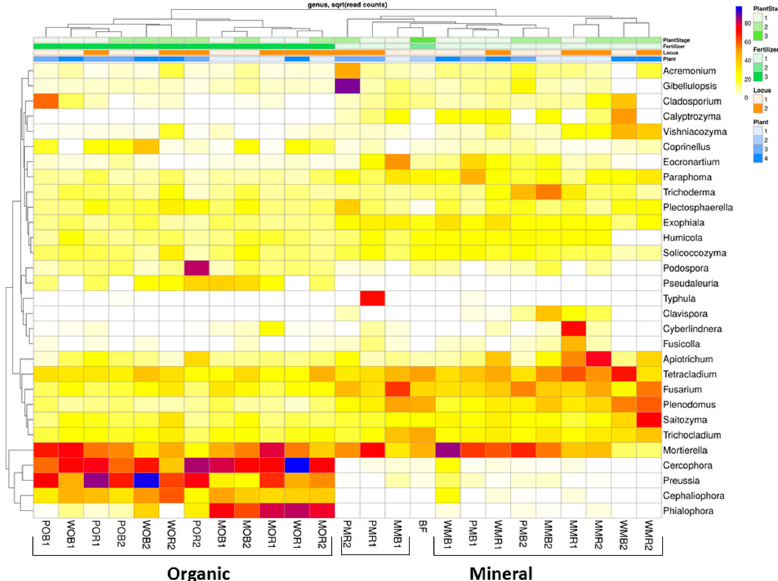
Figure 4. Relative abundances of top 30 fungal taxa in the total (DNA) fungal communities of the considered treatments at the genera level ( N = 3). The data are given as square roots of the read counts. Abundances of fungal genera increase in a row: white ‒ yellow ‒ red ‒ violet ‒ dark blue. All soil samples are indexed according to the scheme: plant–fertilizer system–soil niche–sampling period. The following indices were used for (I) the crop species: P—potato, W—white mustard, M—maize;